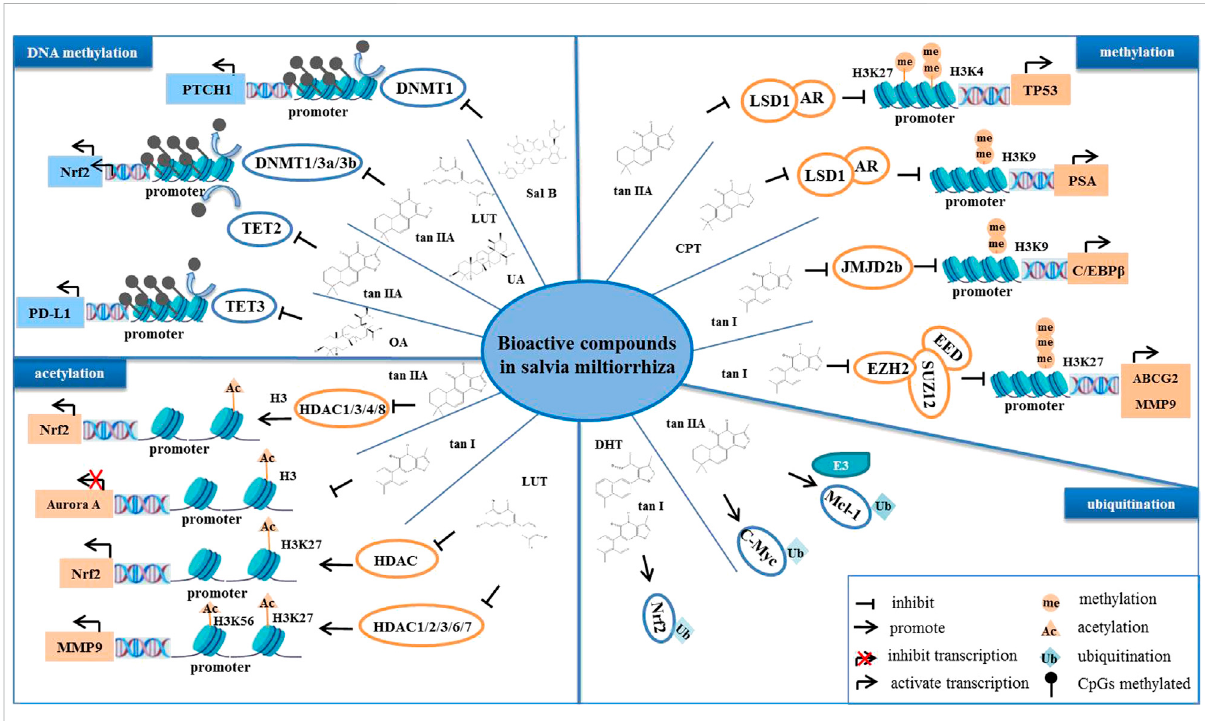
FIGURE 4 The bioactive compounds of S.miltiorrhiza regulateepigeneticmodi fi cations. S.miltiorrhiza bioactive compounds suppress thetranscriptional